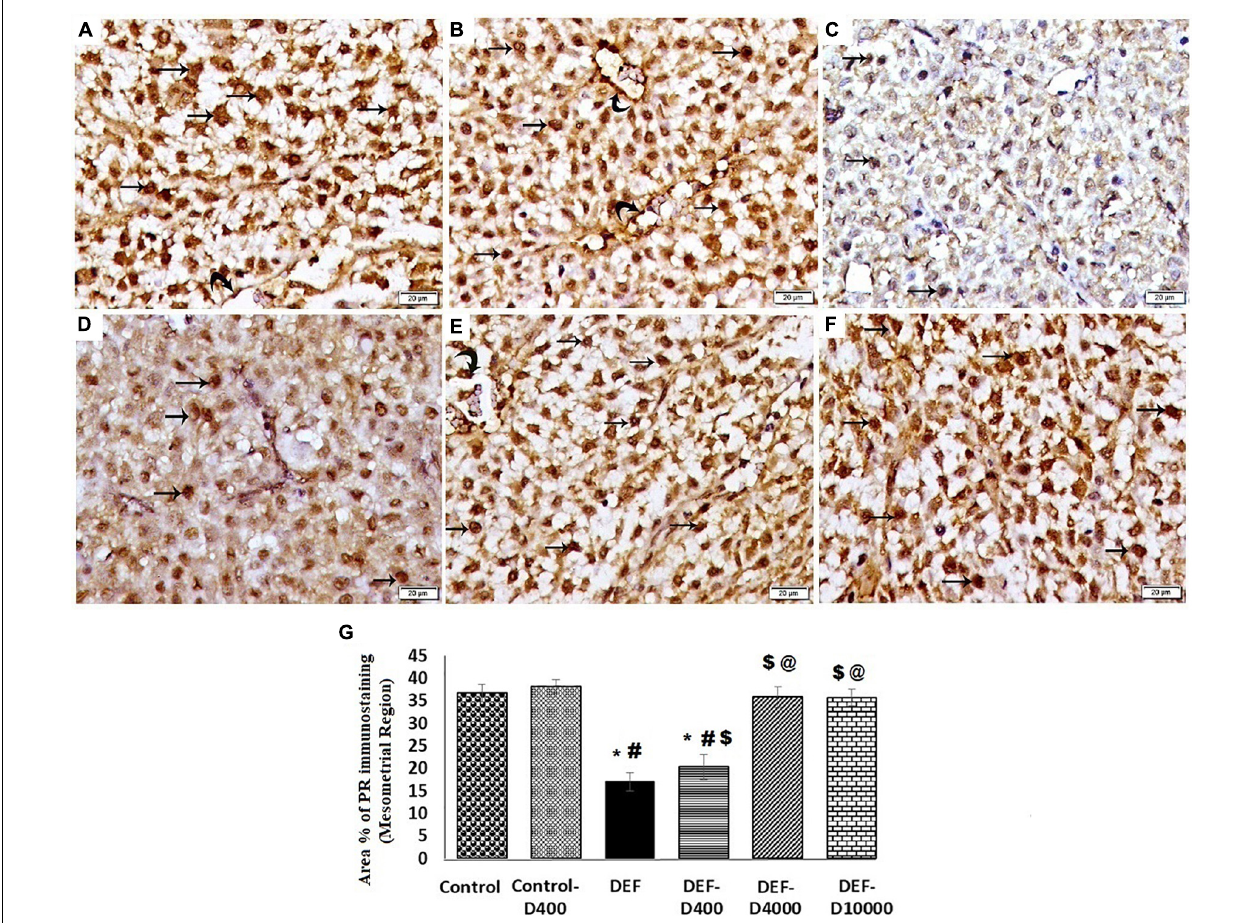
FIGURE 7 | Photomicrograph of the progesterone receptor (PGR) immunostained sections in the mesometrial region of the rat uteri at 8th day of pregnancy ( × 400): (A) Control and (B) Control-D400 revealing strong nuclear immunostaing of PGR in the stromal cells (arrows) and vascular endothelium (curved arrows). (C) DEF displaying weak nuclear immunostaining of PGR in few stromal cells. (D) DEF-D400 illustrating moderate nuclear immunostaining of PGR in some stromal cells. (E) DEF-D4000 and (F) DEF-D10000 demonstrating obvious strong nuclear immunostaing of PGR in the stromal cells (arrows) and vascular endothelium (curved arrows). Scale bar 20 µ m. (G) Quantification of the mean area % of PGR positive immunostaining in the mesometrial region of the rat uteri at 8th day of pregnancy. D: refers to vitamin D supplementation in different doses equivalent to 400, 4,000 and 10,000 IU. DEF: refers to vitamin D deficiency ∗ : Statistically significant